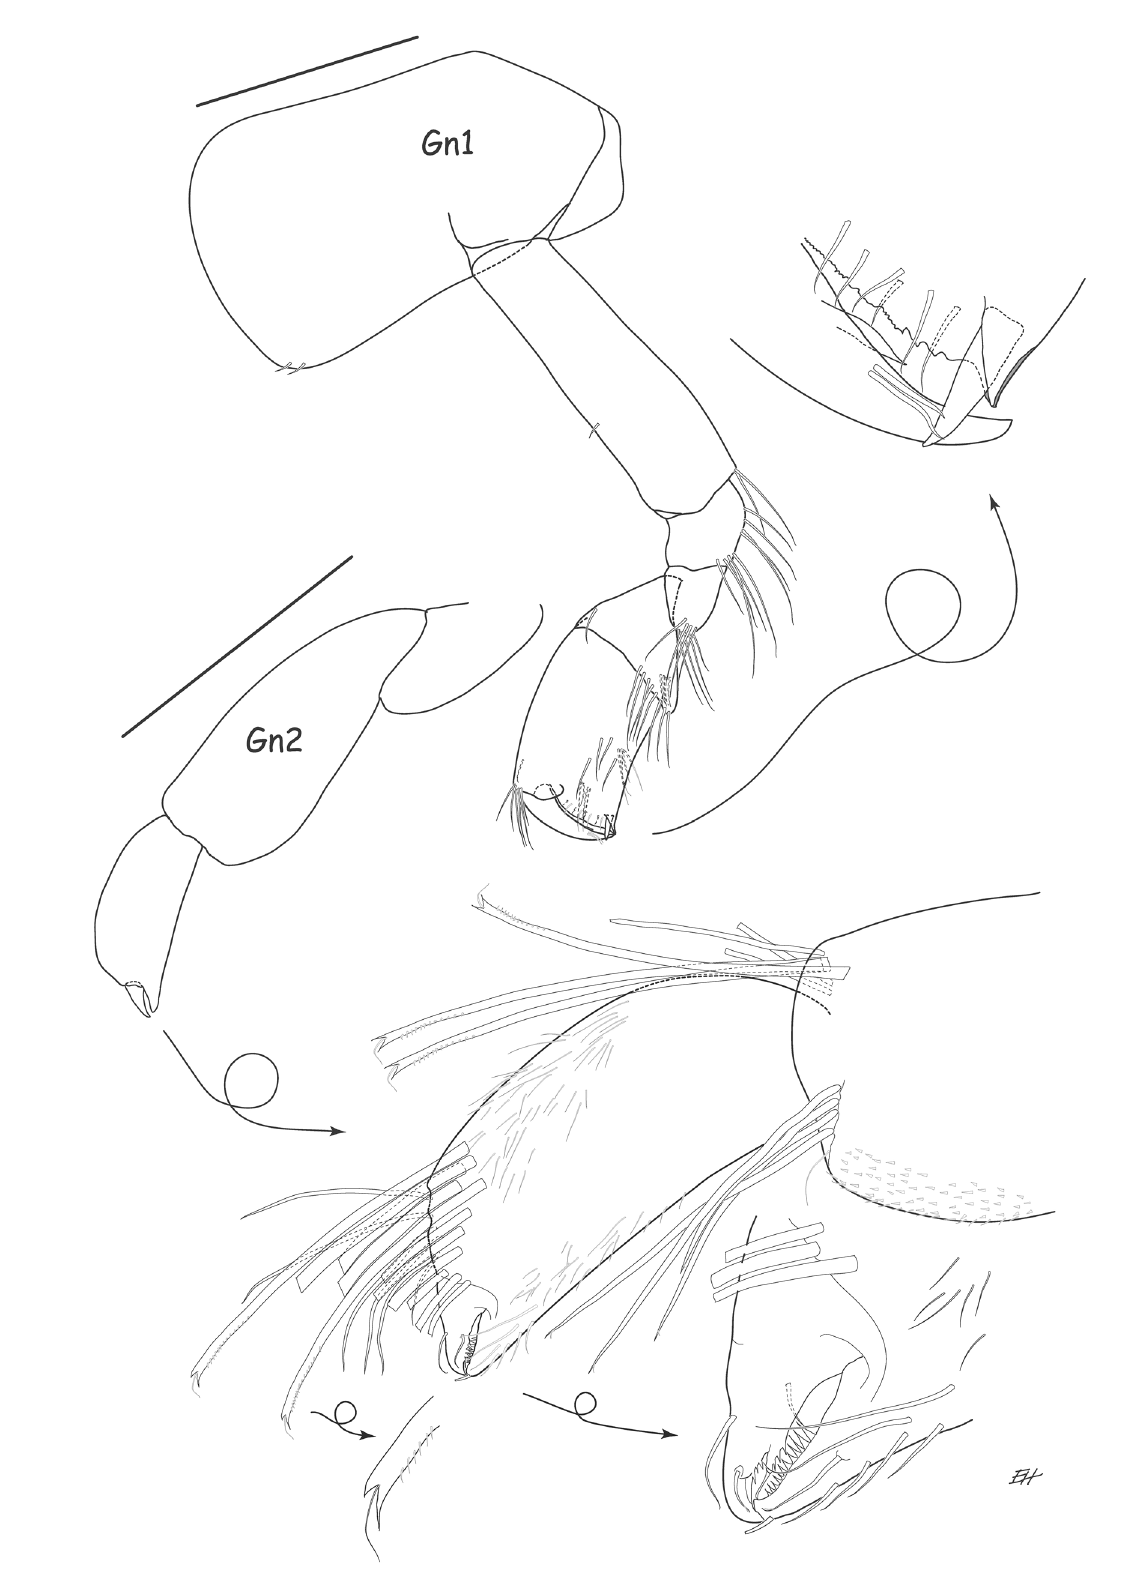
Fig. 8. Abyssorchomene abyssorum (Stebbing, 1888), holotype, ♂, 7.5 mm (BMNH 1889.5.15.23). Setae omitted on merus-propodus outline of Gn2. Scale bars = 1